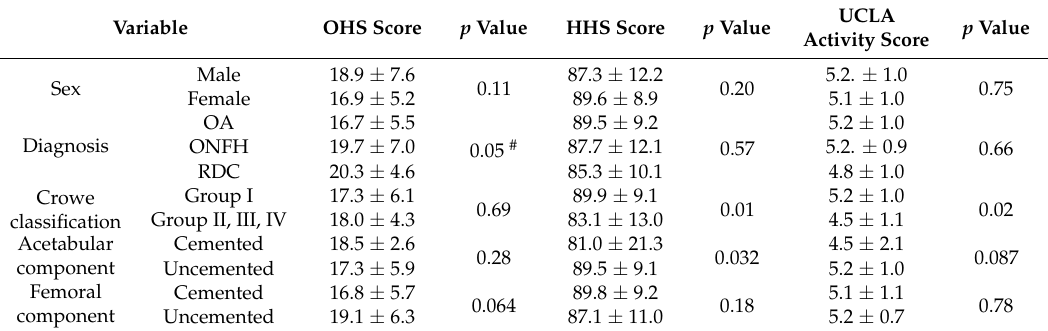
Table 4. Clinical scores 3 months after total hip arthroplasty.